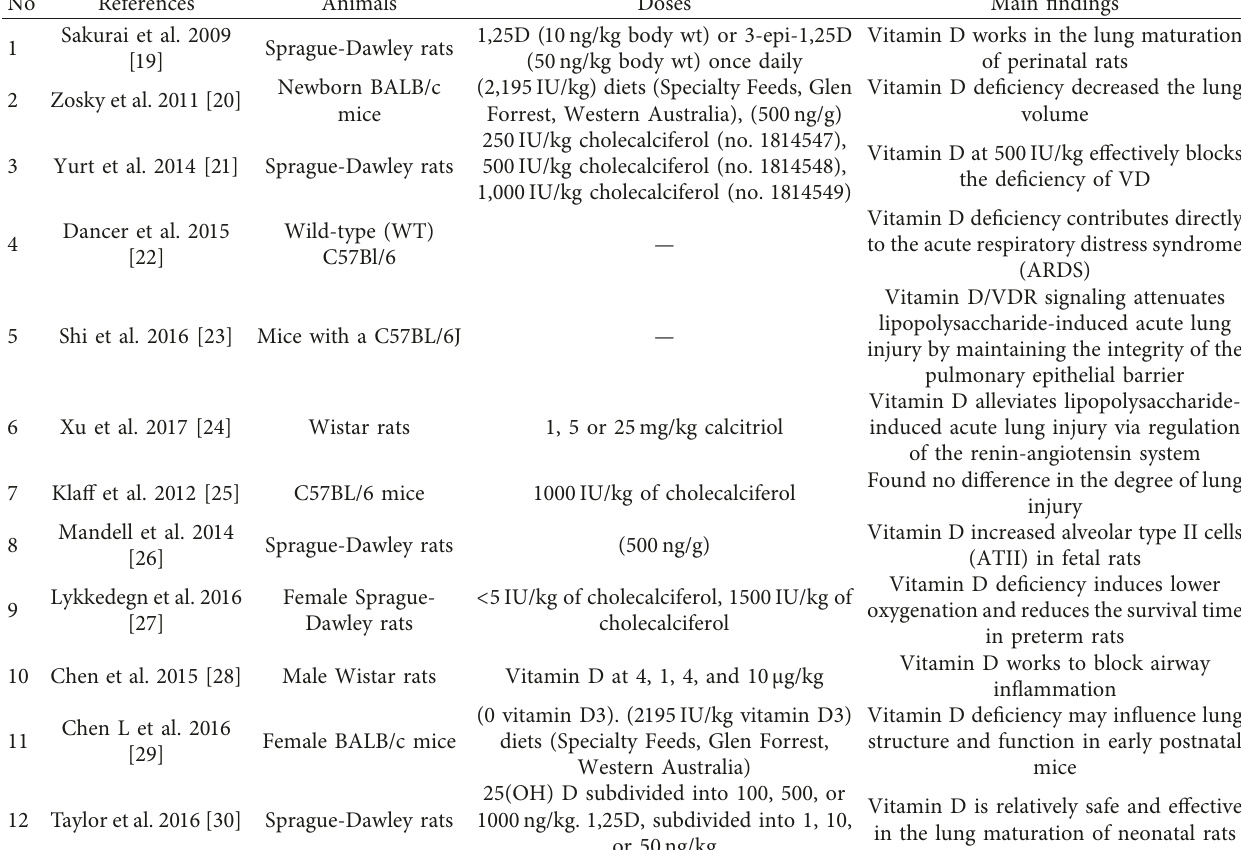
Table 2: Reports of the correlation between vitamin D deficiency and respiratory distress syndrome in animal studies.